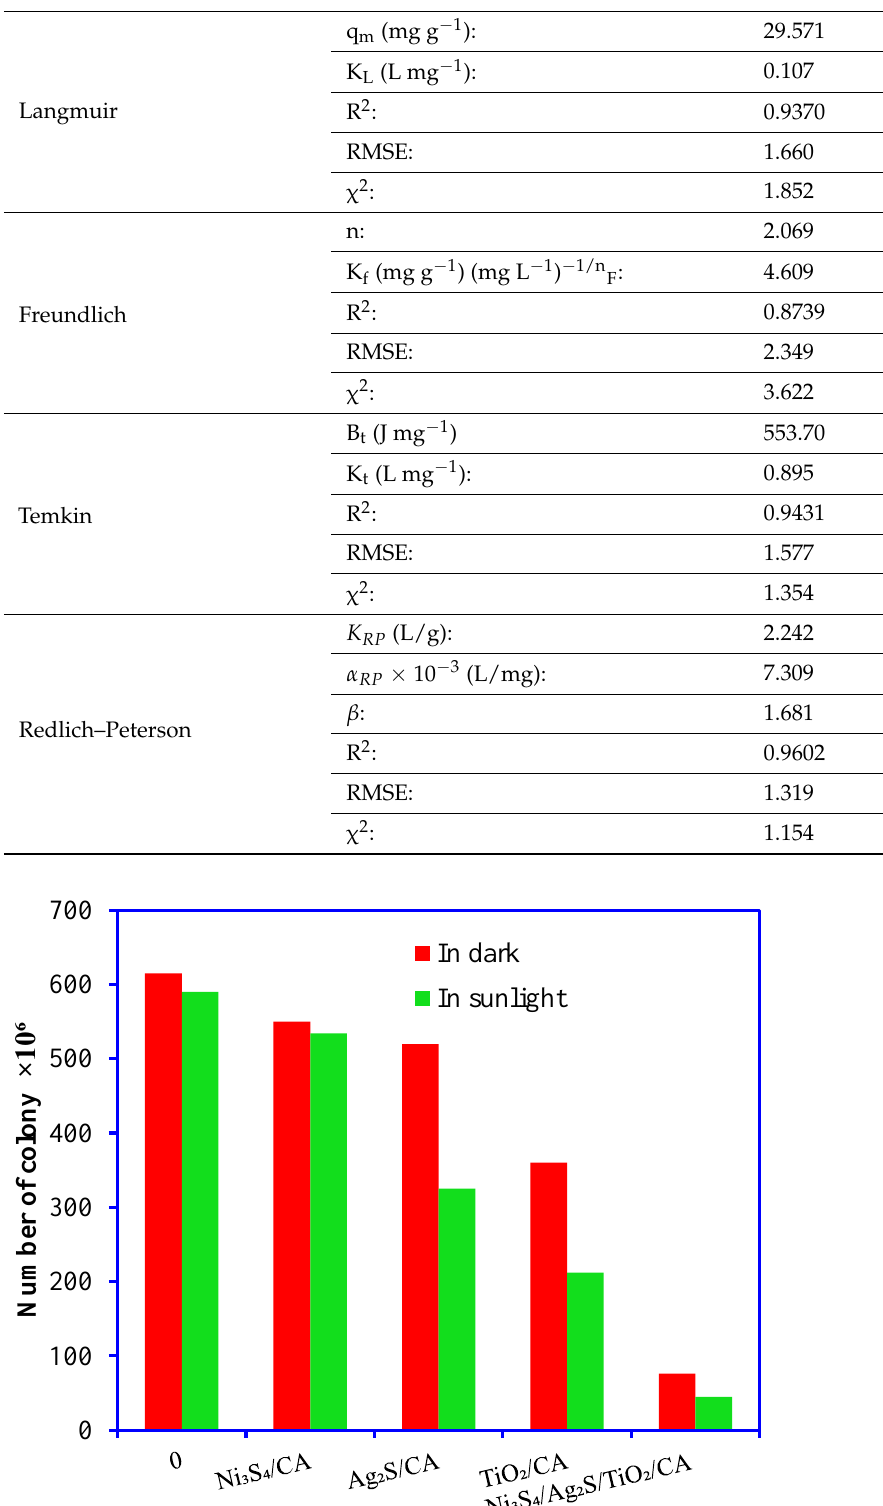
Figure 12. Microbial decontamination properties of Ni 3 S 4 /CA, Ag 2 S/CA, TiO 2 /CA, and Ni 3 S 4 /Ag 2 S/TiO 2 /CA aerogels against the native microbial culture in the absence and presence of sunlight (aerogel dose 100 µg /mL).